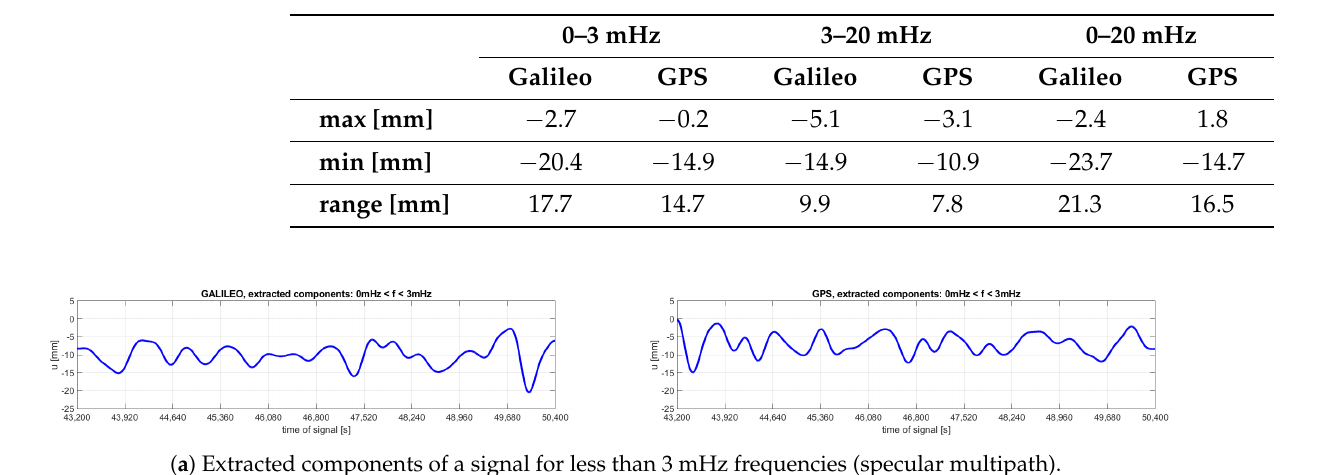
Table 7. Maximum multipath error for vertical component measurements determined from decom- position of the signal.